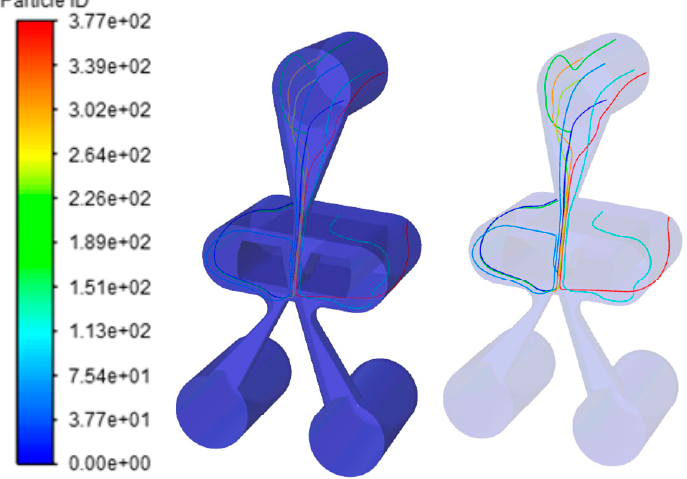
Figure 11. The trajectory of the particles.